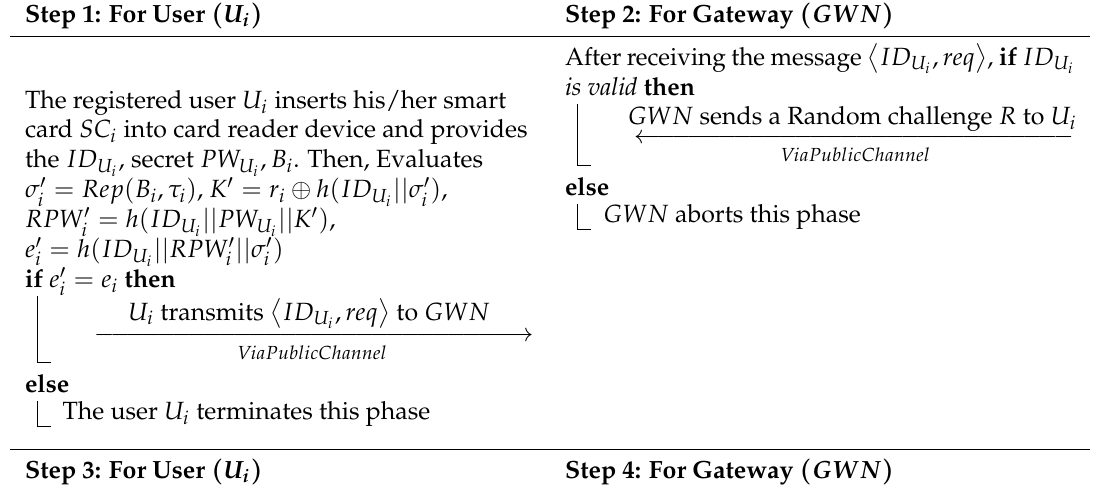
Table 3. Login, authentication and key sharing phase of A.K.Das’s